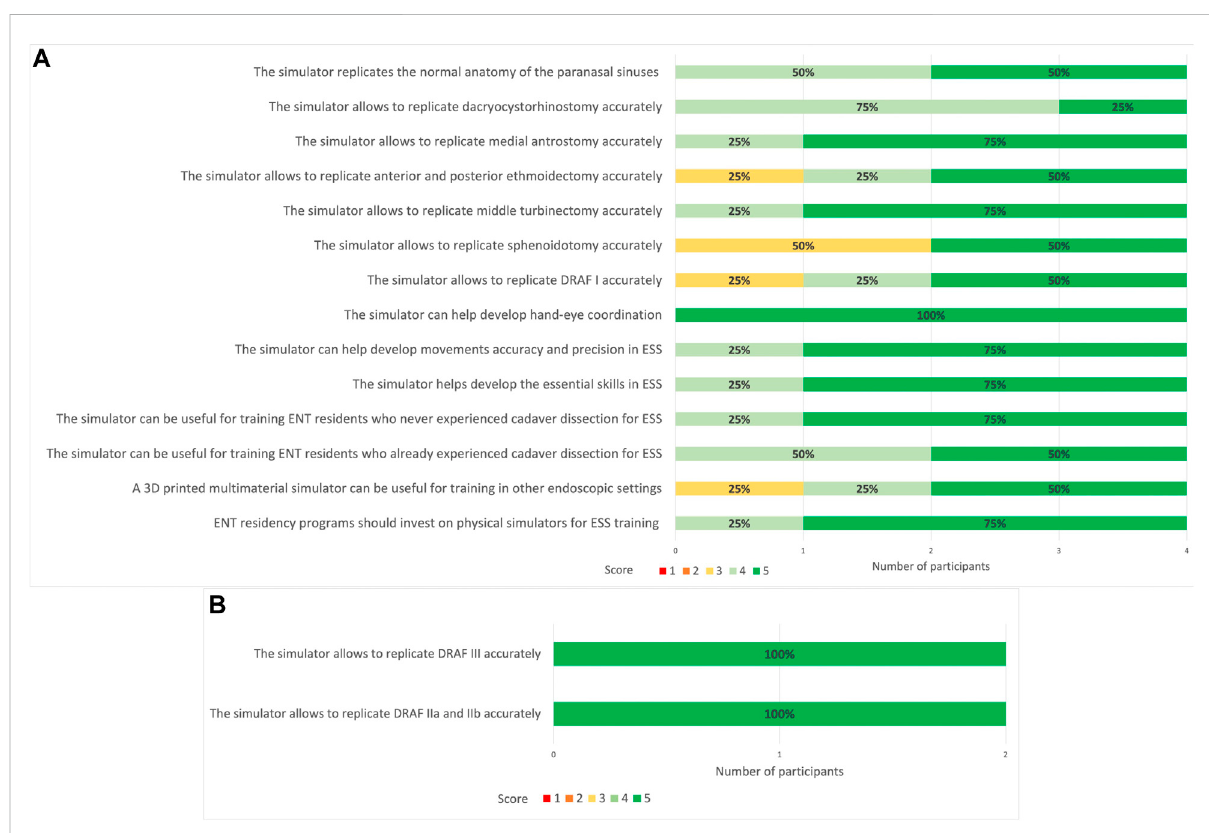
FIGURE 15 (A) 5-point Likert scale ratings for each question given by all participants (ENT experts). 1: strongly disagree; 2: disagree; 3: neutral; 4: agree; 5: strongly agree. (B) 5-point Likert scale ratings for DRAF II a, b and DRAF III given by the two experts. 1: strongly disagree; 2: disagree; 3: neutral; 4: agree; 5: strongly agree. In bold are reported the percentages for each rating given by the different members of the